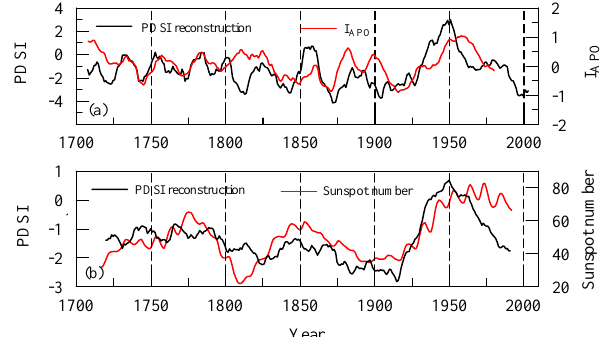
Fig. 9. Comparisons (a) between the 11yr moving average of the PDSI reconstruction and the summer I APO (Zhou et al., 2009) and (b) between the 35yr moving average of the PDSI reconstruction and the sunspot number time series.